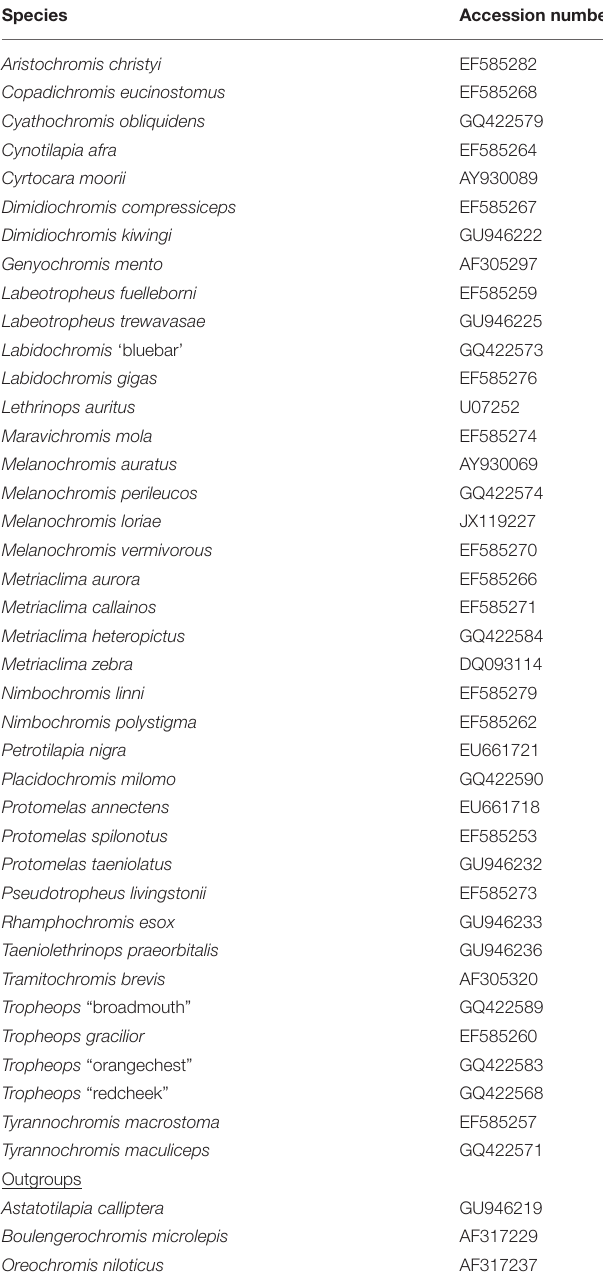
TABLE 1 | Species used in phylogenetic analyses and GenBank accession numbers for ND2